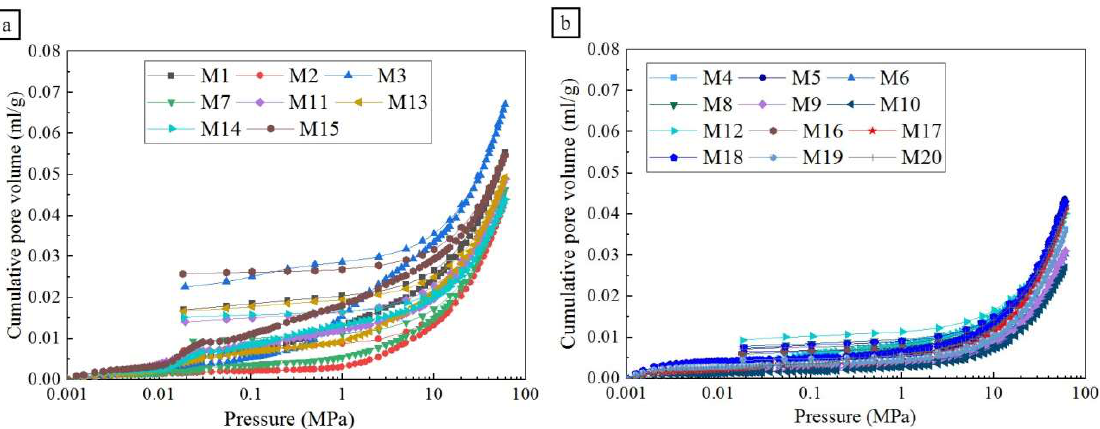
Figure 3. HPMI intrusion and extrusion curves of high-rank coal samples with significantly noncoincident in the ( a ) and more reversible features in the ( b ).